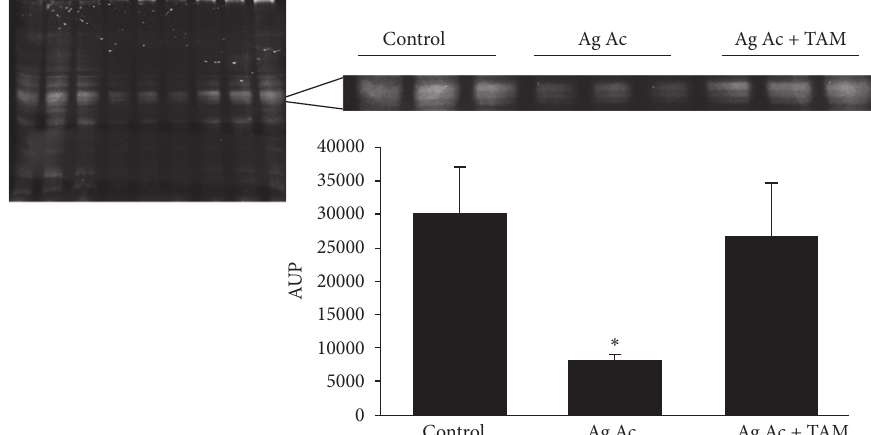
Figure 5: Effect of tamoxifen on the diminution of EMA binding to the adenine nucleotide translocase. Experimental conditions were as indicated in Materials and Methods. Where indicated, 3 µ M agaric acid (Ag Ac) and 20 µ M tamoxifen (TAM) were